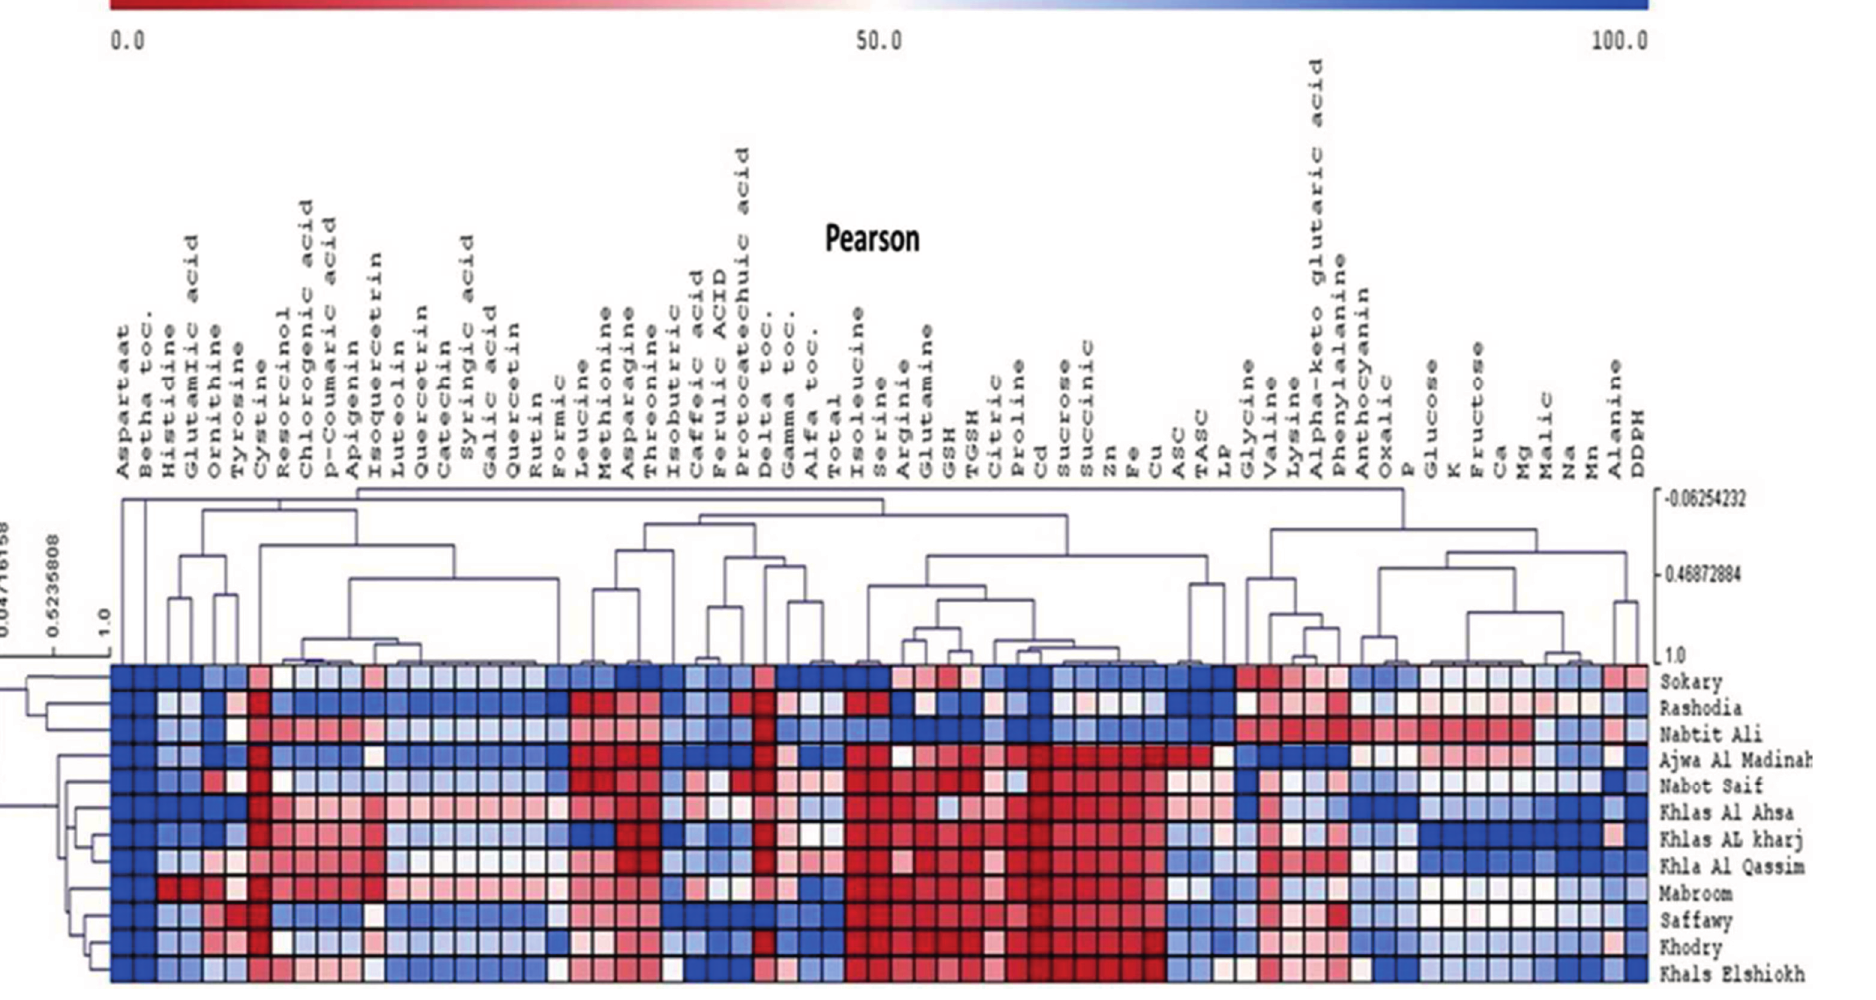
Figure 3. Heat maps of the metabolite profiles of 12 Saudi date cultivars. A total of 42 metabolites were quantified by high performance liquid chromatography for each cultivar, including amino acids, organic acids, sugars, phenolic compounds, glutathione and